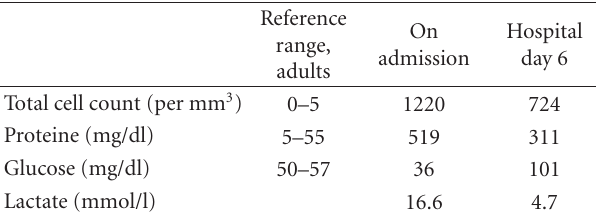
Table 1: Cerebrospinal fluid